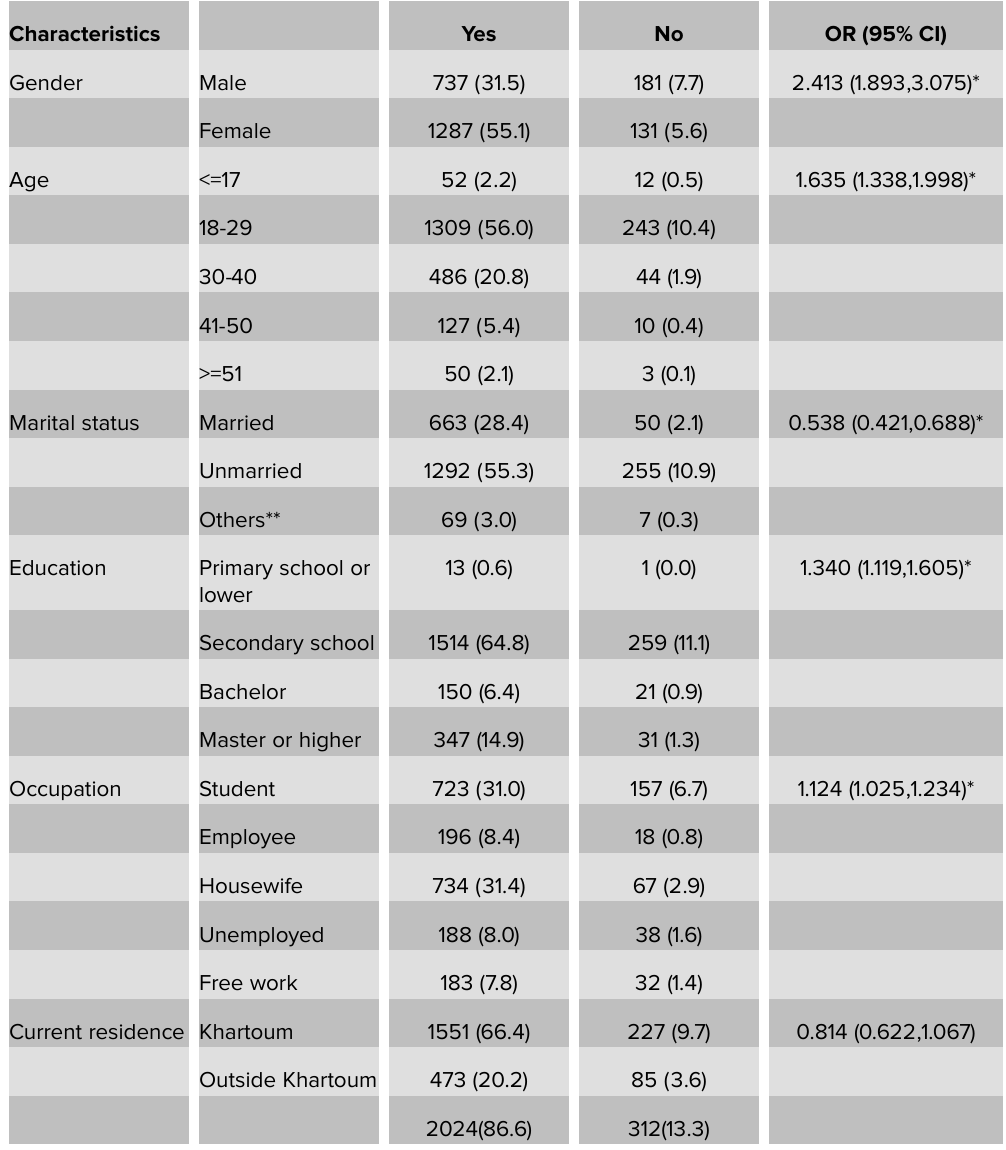
TABLE 8: Practices towards COVID-19 by demographic variables, (When coughing or sneezing do you use the tissue?)